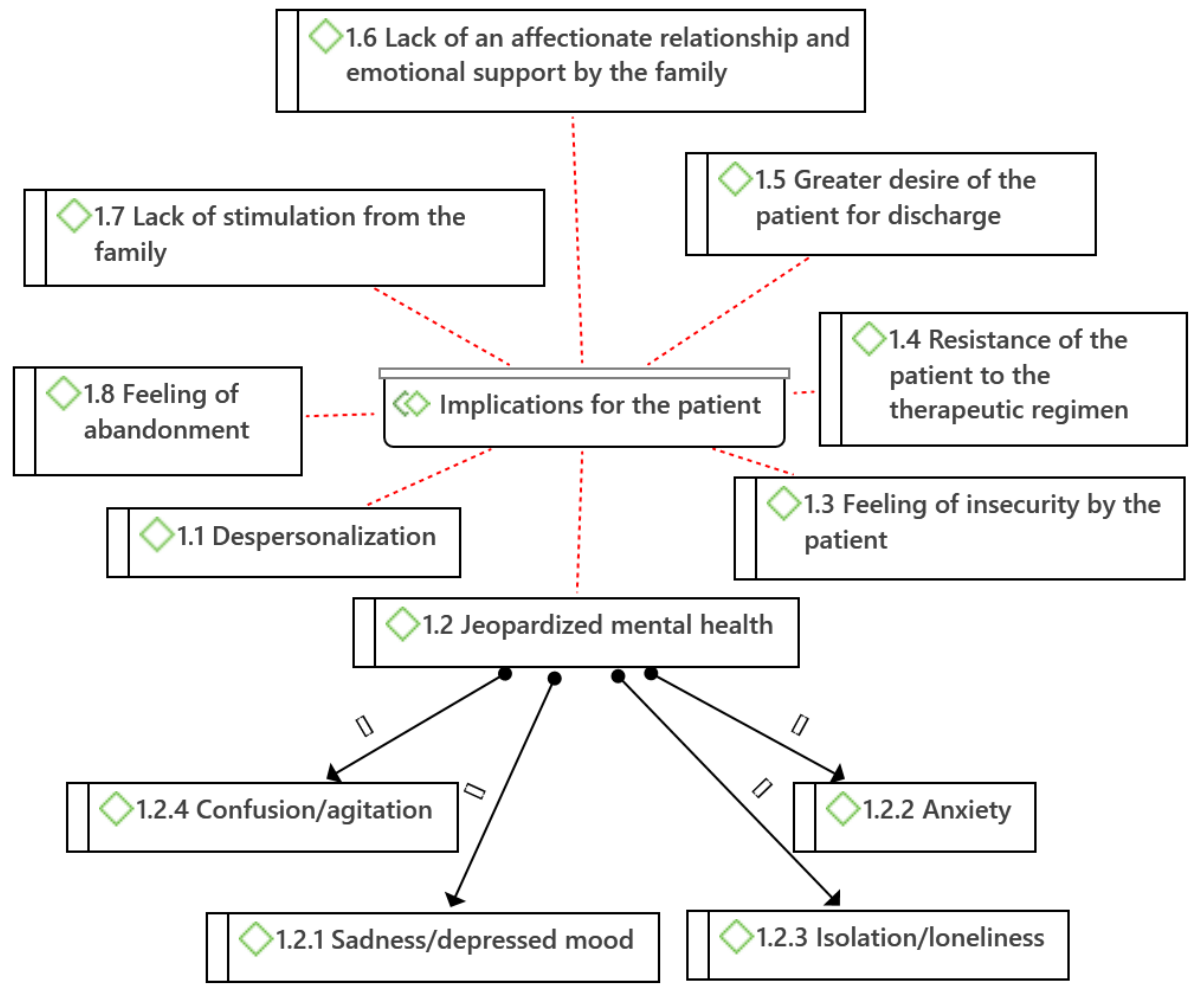
Figure 2. Categories and subcategories of implications for the patient of hospital visit restriction measures (Atlas.ti ® ).